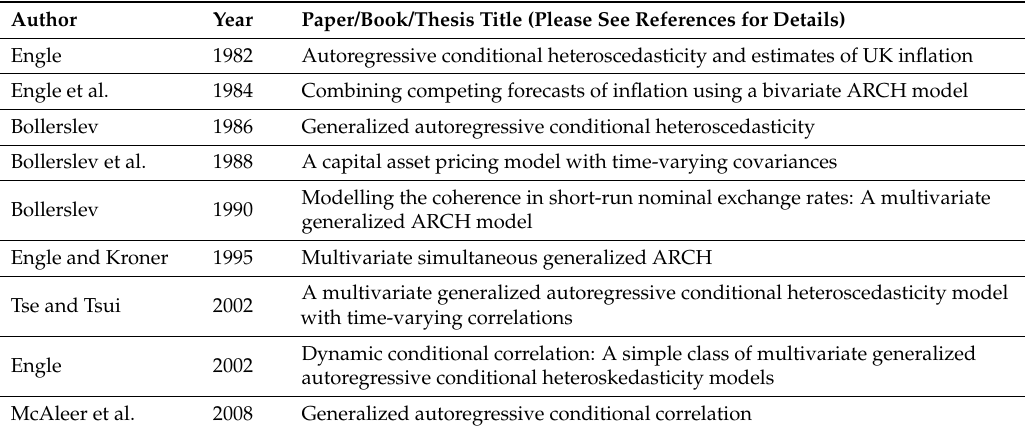
Table 3. Selected work on Correlation/Covariance and